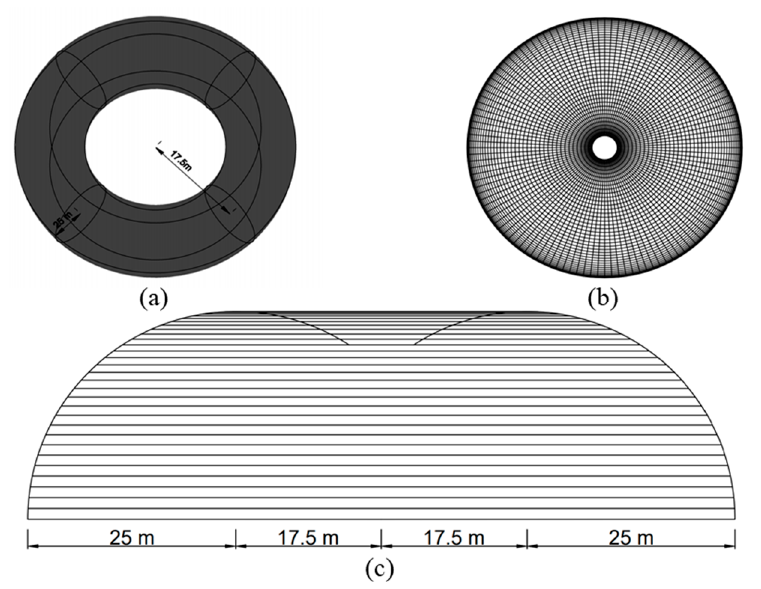
Figure 2. Schematic design of the model ABAQUS: ( a ) isometric view; ( b ) top view; ( c ) front view.